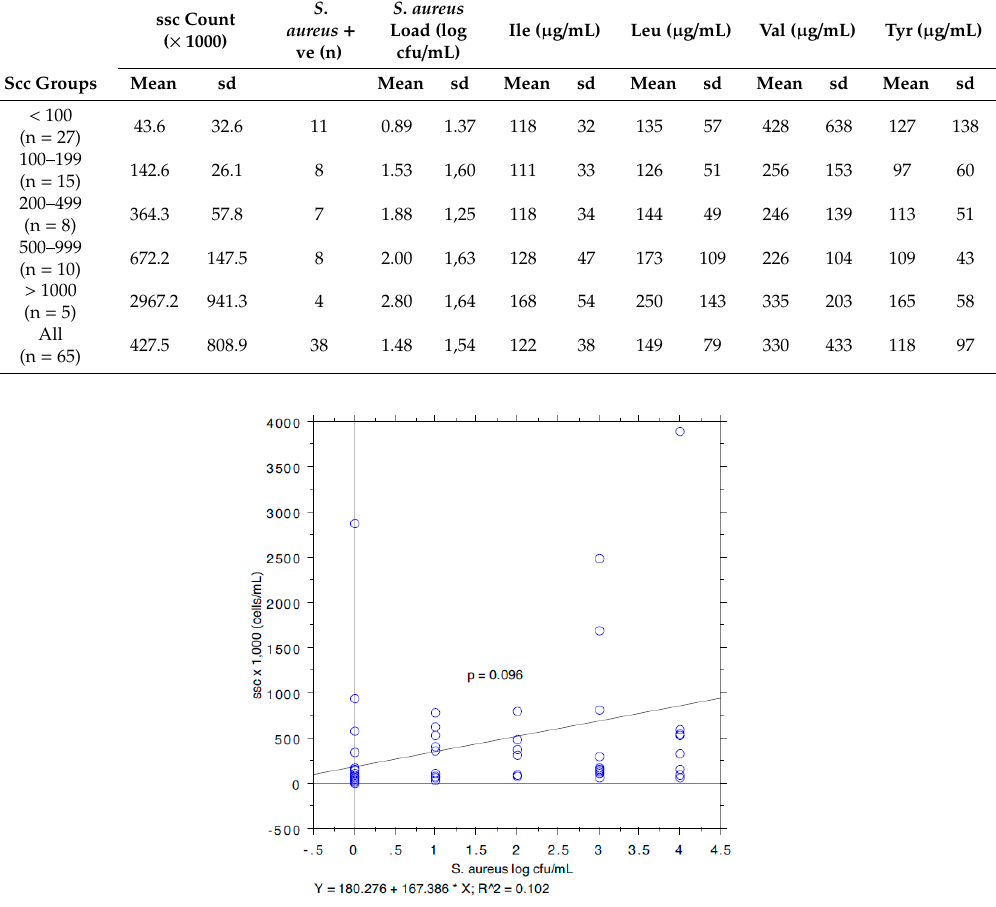
Figure 1. Pearson correlation between SCC and S . aureus load.